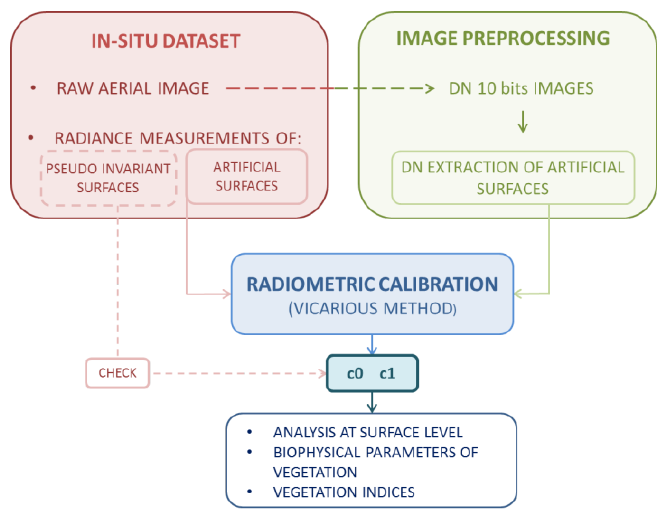
Figure 7. Workflow of the radiometric calibration